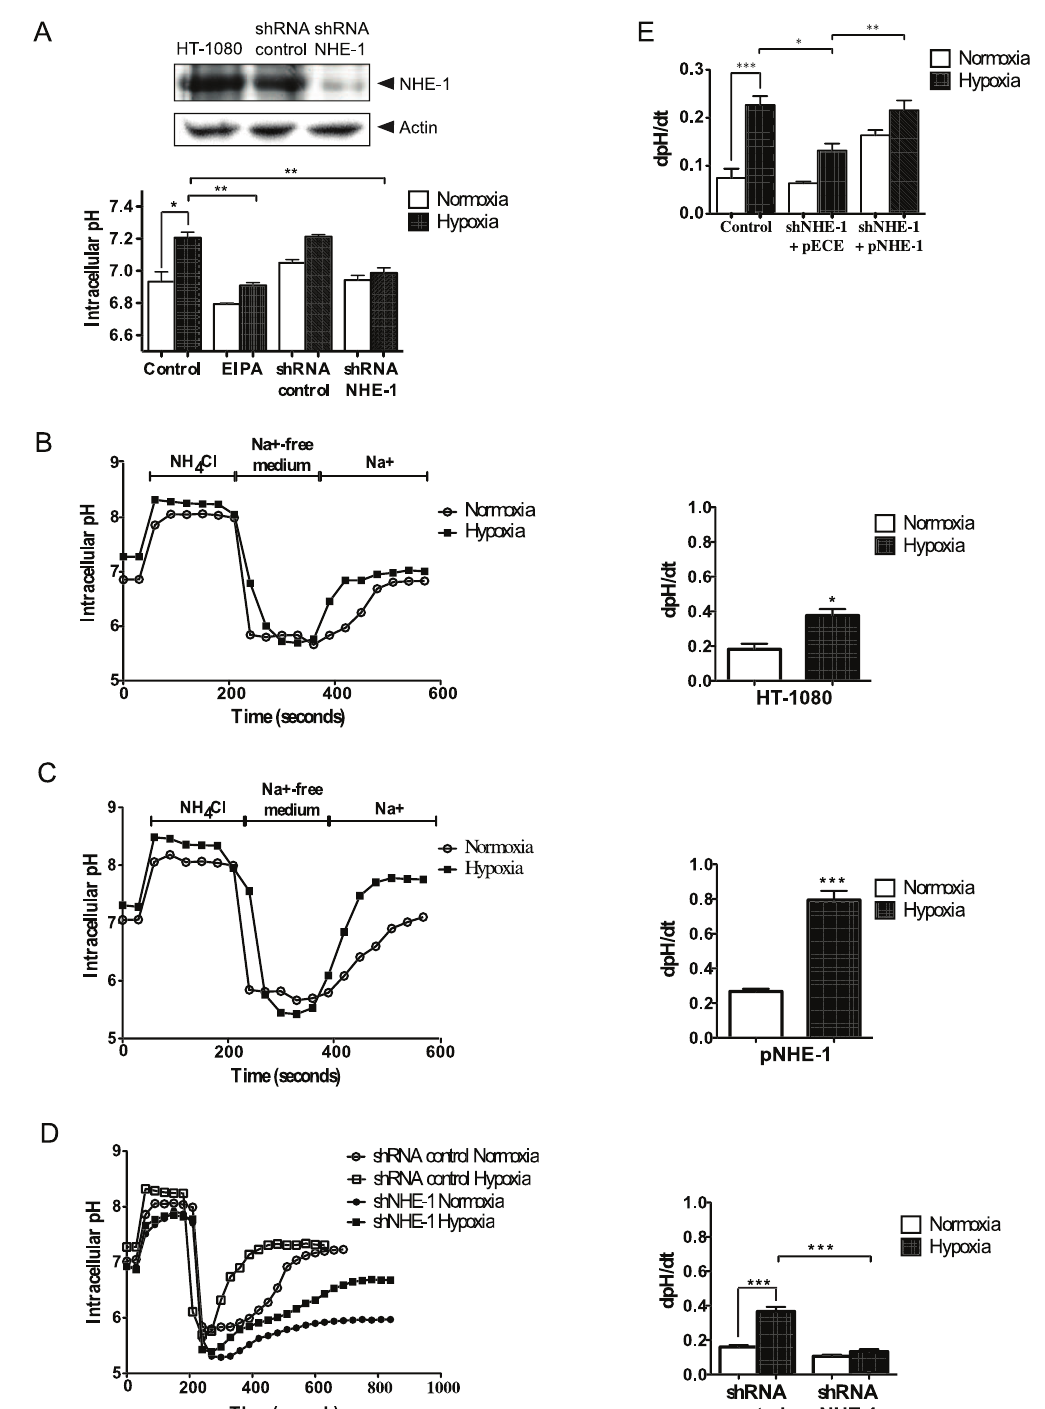
Figure 1. Hypoxia increases NHE-1 activity in HT-1080 cells. (A) Control (untransfected) HT-1080 cells incubated in the presence or absence of the NHE-1 inhibitor, EIPA (25 m M), or cells transfected with scrambled (control) shRNA, or NHE-1 shRNA, were incubated for 4 h under normoxic or hypoxic conditions. Basal intracellular pH (pH i ) was measured using BCECF (n=300 cells). Immunoblot showing knock down of NHE-1 expression in NHE-1 shRNA transfected cells. Actin was used as a loading control. (B–D) Representative traces showing pH i recovery after ammonium chloride- prepulse-induced acidification in HT-1080 cells cultured under normoxic or hypoxic conditions with associated bar graph showing Na + /H + exchange rates (n=300 cells per condition), for (B) untransfected cells, (C) cells transfected with p-NHE-1, or (D) cells transfected with control shRNA or NHE-1 shRNA. (E) Rescue experiments were performed by transfection of NHE-1 shRNA-transfected cells with pNHE-1. Na + /H + exchange rates were measured in cells exposed to normoxic or hypoxic conditions. Columns represent the mean 6 SEM indicated by the horizontal bars. The asterisks correspond to, * p , 0.01; ** p , 0.001; *** p , 0.0001.